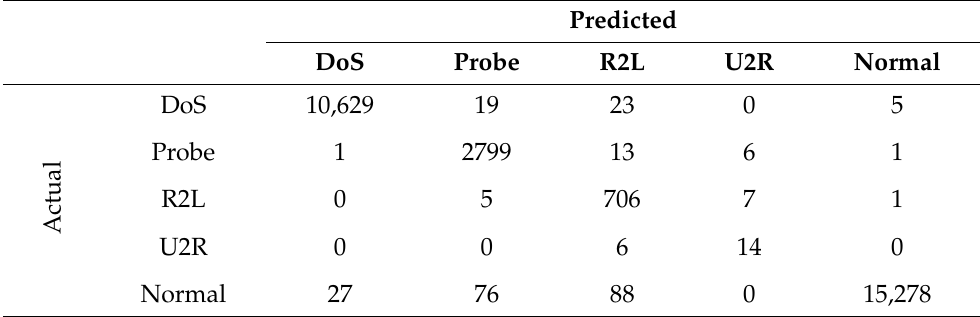
Table 13. Confusion matrix for NSL-KDD “class weights” multiclass classification